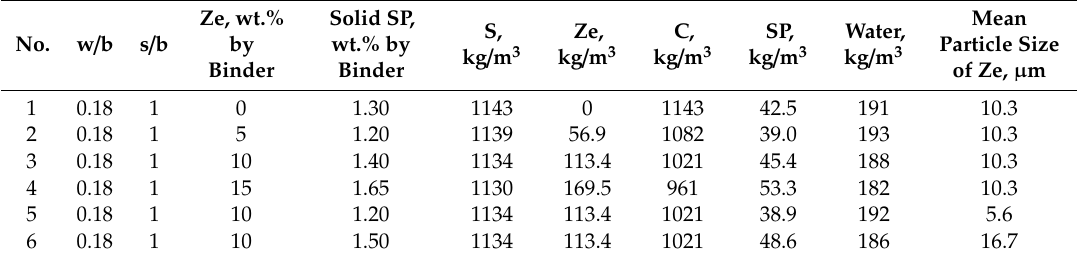
Table 3. The binder herein is the total of the cement and zeolites. Table 3. Mix composition of high-performance cement-based concrete (HPC) specimens.